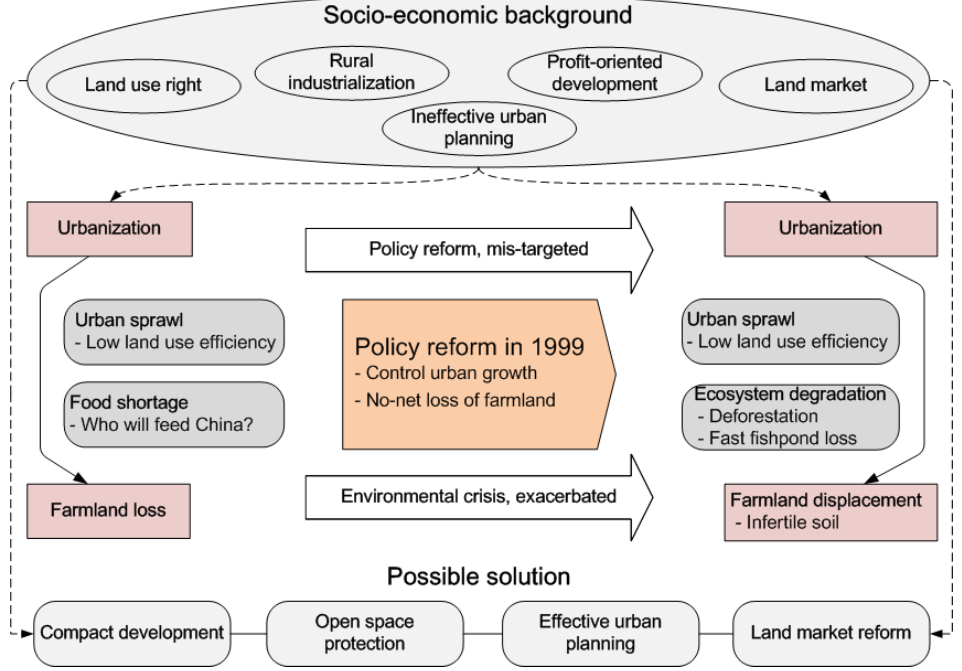
Figure 6. The land use change mechanism and possible